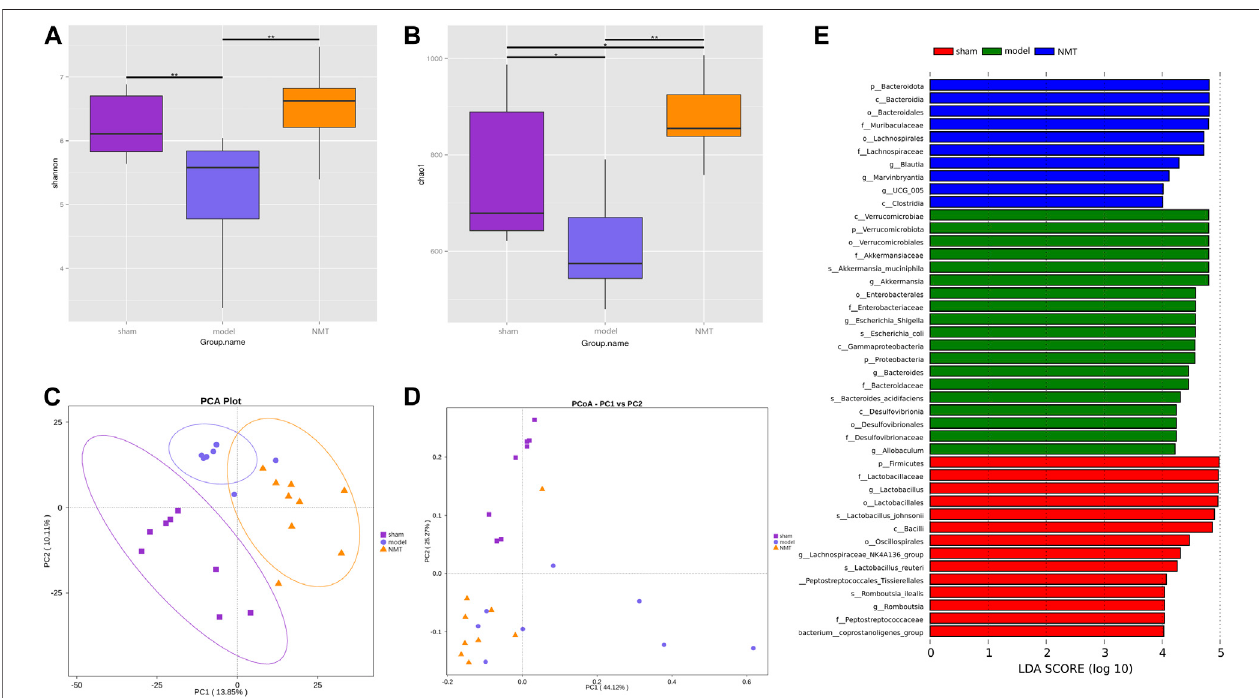
FIGURE3| Theadjustmentofthestructure oftheintestinal fl orawasbene fi cialtotheprognosisofstroke. (A,B) TheShannonindex andchao1indexof α diversity. (C,D) Analysis of β diversity of intestinal fl ora in rats. PCA analysis and Weighted UniFrac PCoA analysis of gut microbiota based on the OTU data of sham, model, and NMT groups. Each point represents a sample. A clear separation is observed between the samples of sham ( n (cid:1) 8), model ( n (cid:1) 7) and NMT ( n (cid:1) 9) groups. (E) LEfSe analysis of different groups. Biomarkers at the genus level for each group screened based on LDA score. Different colors represent different groups. All group comparison in fi gures were analyzed with Kruskal – Wallis